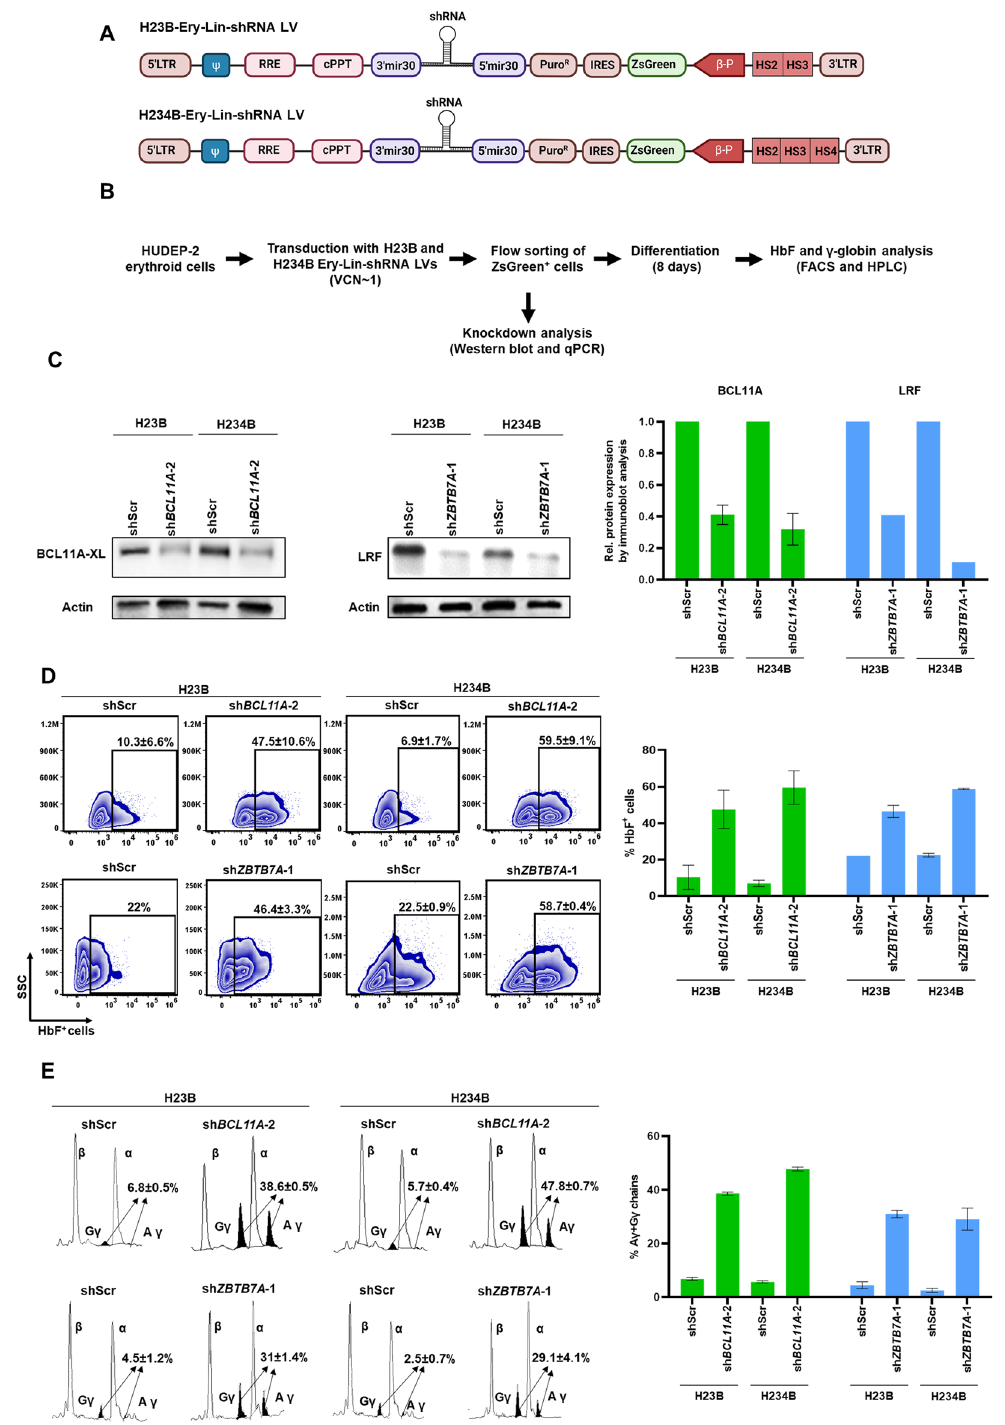
Figure 2. Knockdown of target gene expression in HUDEP-2 cells using H23B and H234B Ery-Lin-shRNA LVs. ( A ) Schematic maps of H23B and H234B Ery-Lin-shRNA LVs. HS2, HS3 and HS4: human β-globin LCR hypersensitivity sites 2, 3 and 4, respectively, βp: β-globin promoter and 5’ miR30 and 3’ miR30: 5 ′ and 3 ′ regions of the mir30 scaffold sequence, respectively. ( B ) Workflow of the experiment for target gene knockdown by the Ery-Lin-LVs in HUDEP-2 cells. ( C ) Representative immunoblots to evaluate the knockdown efficiencies of sh BCL11A and sh ZBTB7A in the transduced HUDEP-2 cells (left) and the graphical representation of the densitometric data of the immunoblots (right). Full blots are presented in Supplemental Fig. S9 and S10. ( D ) Intracellular HbF analysis by flow cytometry to determine the percentages of HbF + cells in the shRNA transduced HUDEP-2 cells after differentiation. ( E ) HPLC analysis of the percentages of Gγ+Aγ chains in the shRNA transduced cells after differentiation (left) and graphical representation of the data (right). H23B and H234B represent H23B-Ery-Lin-shRNA and H234B-Ery-Lin-shRNA LVs, respectively. All data represent mean ± SD (n =